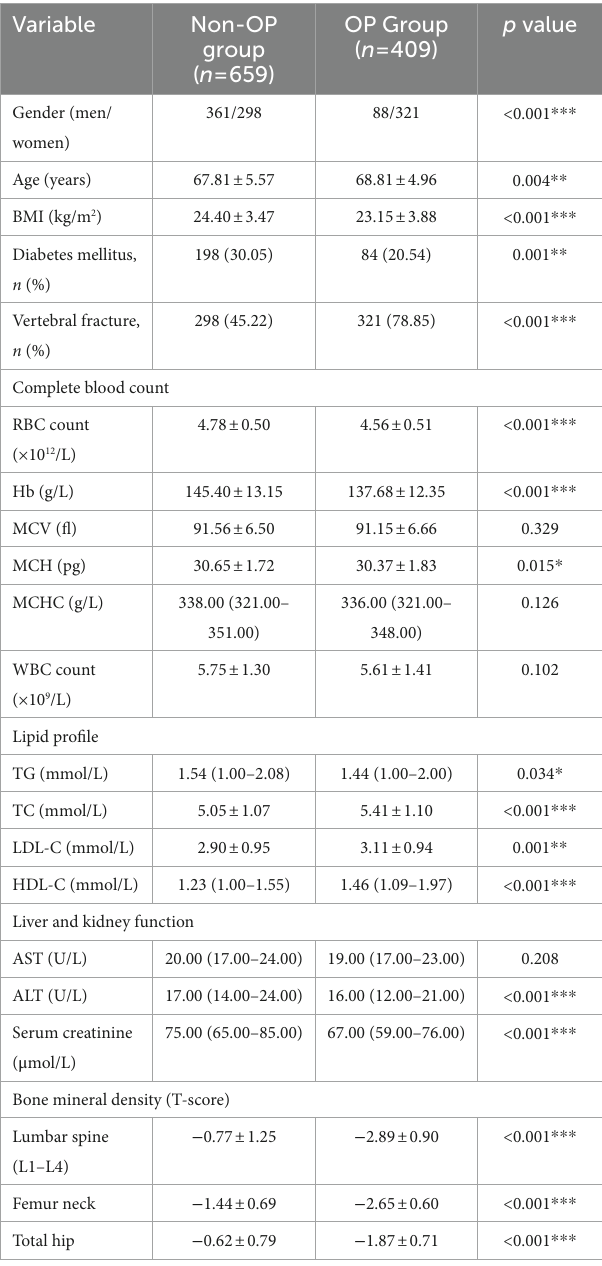
TABLE 1 Demographic and clinical characteristics of individual with/ without